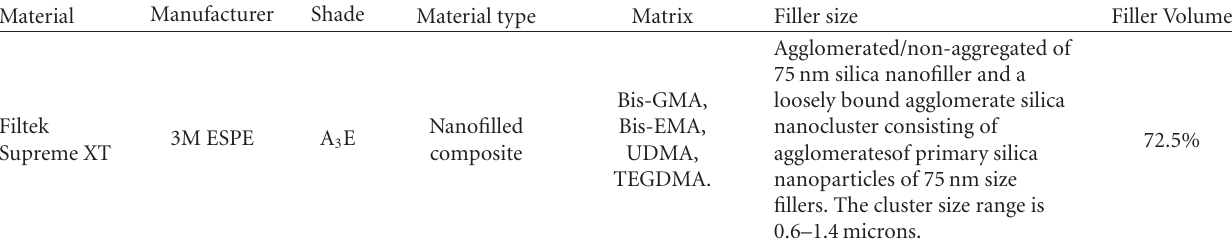
Table 1: Characteristics of restorative material used in the study (manufacturers’ informations).